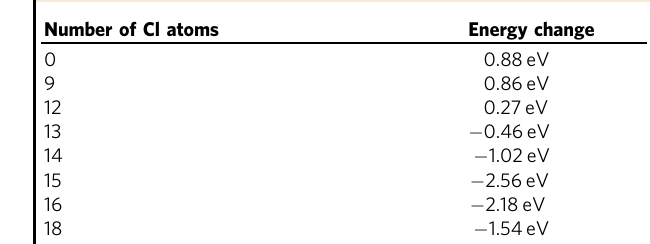
Table 1 System energy change on stacking fault removal with varying amounts of Cl in the Σ 3 structure of Fig. 5a, b.